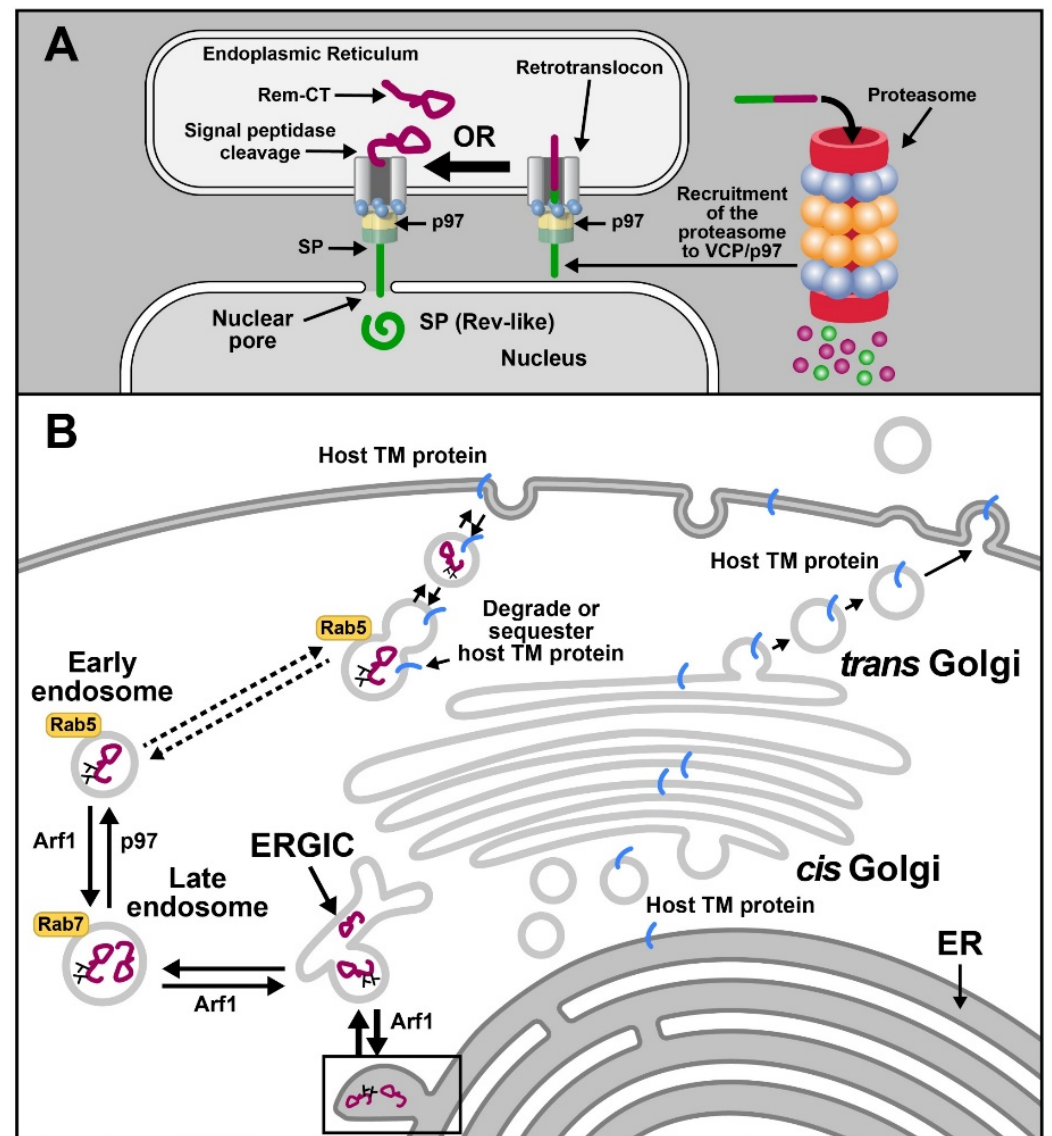
Figure 4. VCP/p97 and its function in retroviral protein trafficking. ( A ) Processing of the MMTV-encoded Rem protein. Rem is synthesized as a precursor at the ER membrane. A portion of Rem is extracted through a retrotranslocon by VCP/p97 and is degraded by the proteasome. The involvement of VCP adapters in this process is unknown. The majority of Rem appears to be cleaved by signal peptidase into a functional HIV-1 Rev-like protein, SP (shown in green), and a C-terminal portion, Rem-CT (shown in magenta). SP requires p97 for extraction from the ER membrane and then traffics to the nucleus to bind MMTV RNA. SP binding is necessary for efficient viral RNA export and expression. ( B ) Trafficking of Rem-CT. Rem-CT is glycosylated in the ER (Y-shaped structures) and then emerges through ER exit sites (ERES) prior to localization to the ERGIC using the activity of Arf1. Arf1 also is required for trafficking to the Rab7-positive late endosome compartment. Further anterograde trafficking of Rem-CT to the Rab5-positive early endosomes requires VCP/p97. Rem-CT localization to early endosomes or trafficking to the cell surface may allow sequestration or degradation of host transmembrane proteins that participate in innate or adaptive immunity directed against viral